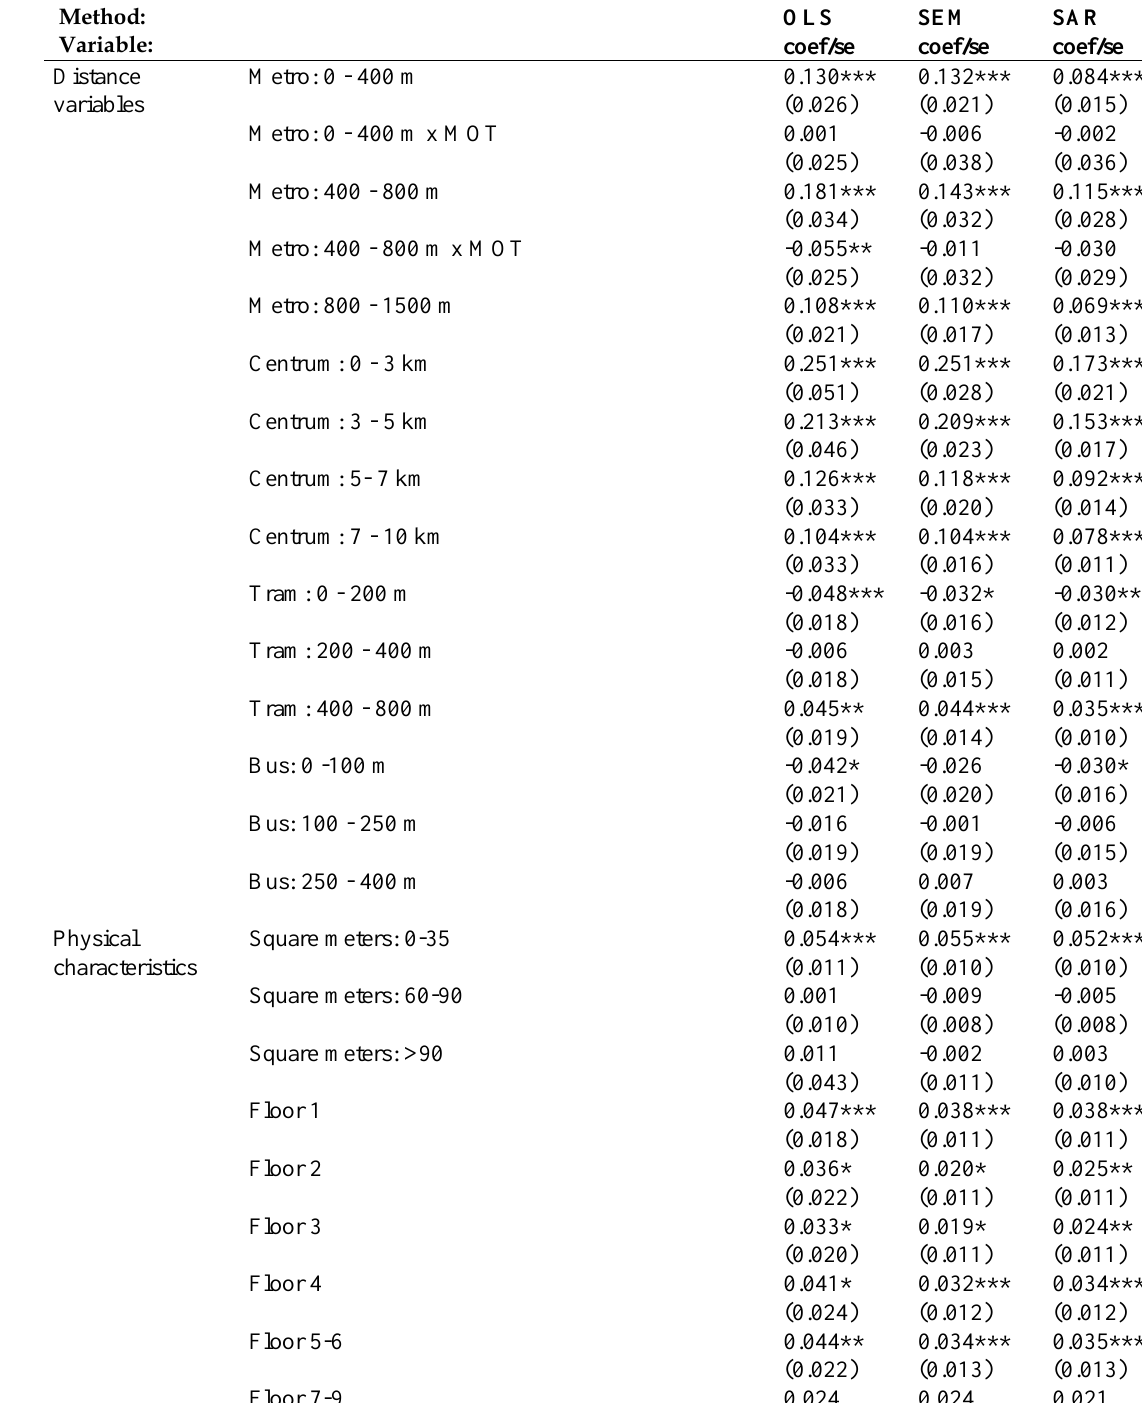
Table A.3. Full estimation output for the model with interaction terms using OLS, SEM